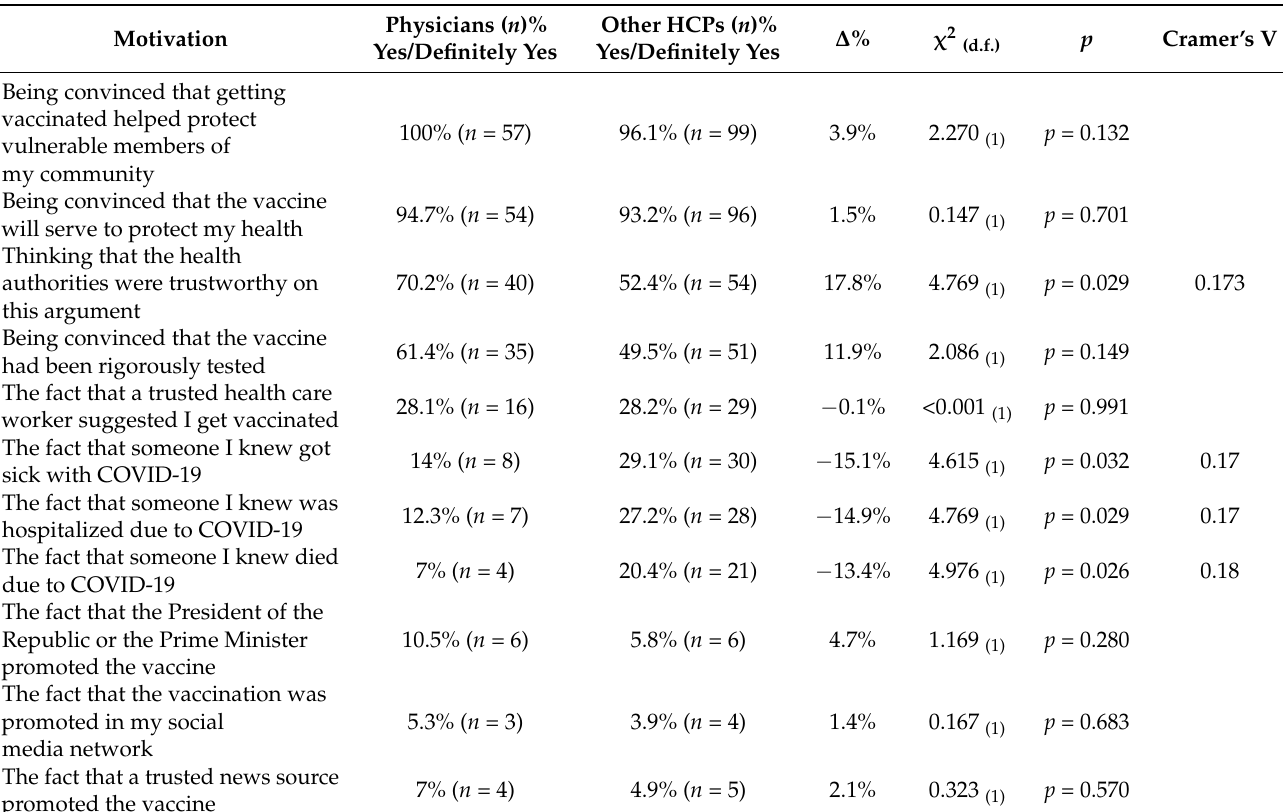
Table 2. Motivation ranking behind COVID-19 vaccination behavior in physicians and other HCPs ( n =